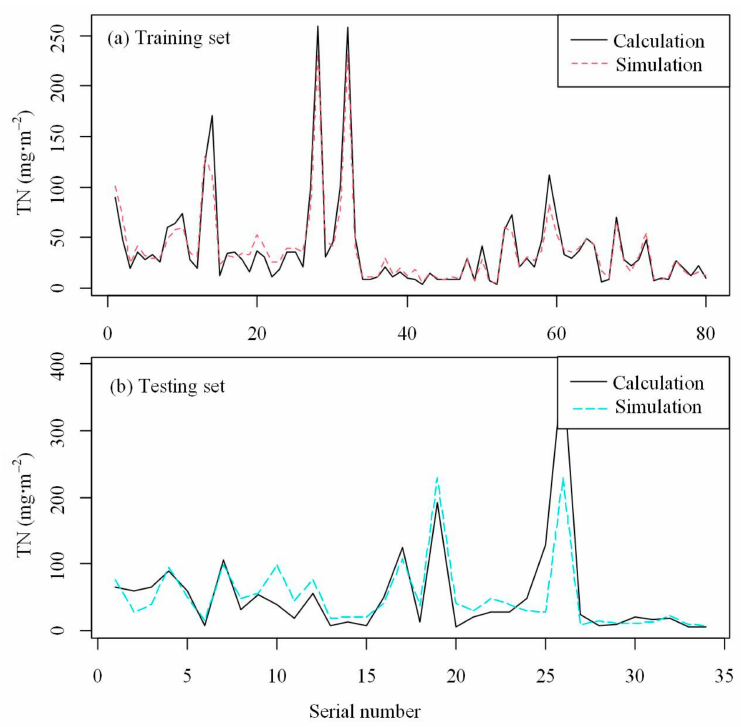
Figure 7. Calculated and simulated runoff TN loads of paddy fields based on RF.